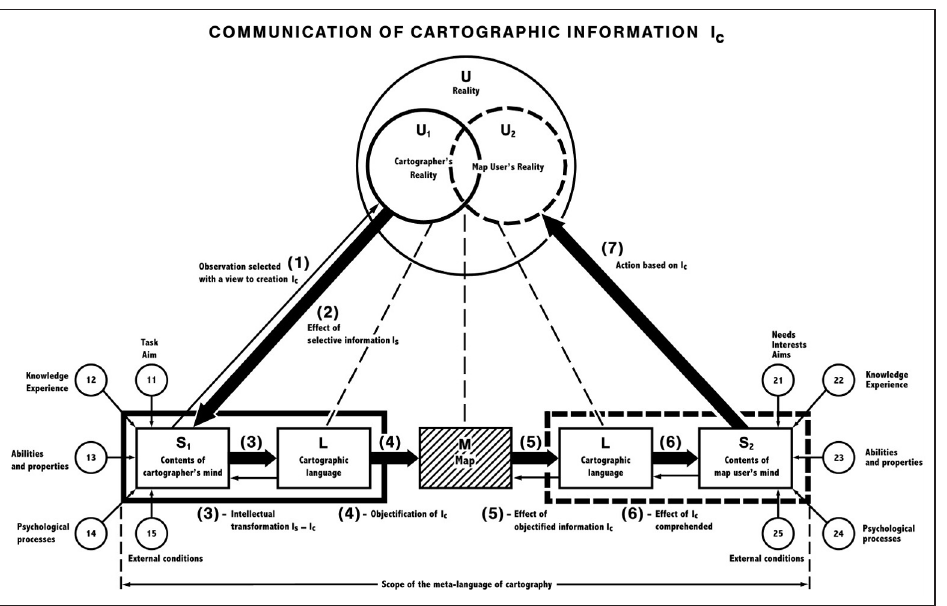
Figure 1: Kolá č ný’s (1969) diagram of the map communication model (redrawn from Kolá č ný, 1969 and reproduced courtesy of the British Cartographic